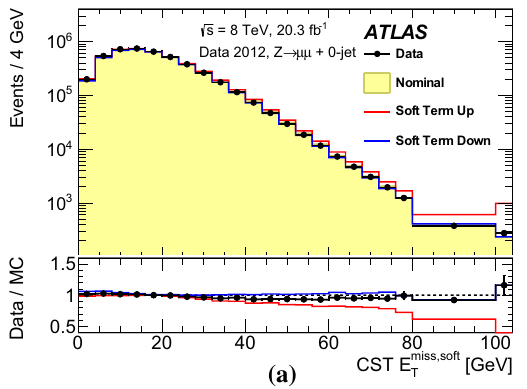
Fig. 24 Distributions of a E miss , soft and b E miss with the CST algo- resulting changes from the variations are added in quadrature, and the T T insets at the bottom of the figures show the ratios of the data to the MC rithm. Data are compared to the nominal simulation distribution as well as those resulting from applying the shifts/smearing according to predictions. The uncertainties are estimated using the balance method described in Sect. . The the scale and resolution systematic uncertainties on the E miss , soft T